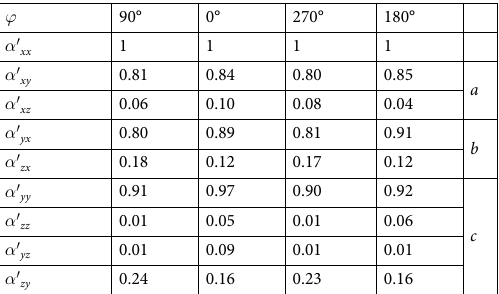
Table 1. Relative magnitudes of Raman tensor elements (normalised to α ′ xx ) of the 1628-cm − 1 MB band for different angles ϕ . The values were obtained by fitting the SERS depolarization ratios using the surface selection rules. Values revealed by the fit of ρ 1 are labelled as a , by ρ 2 as b and by ρ 3 as c